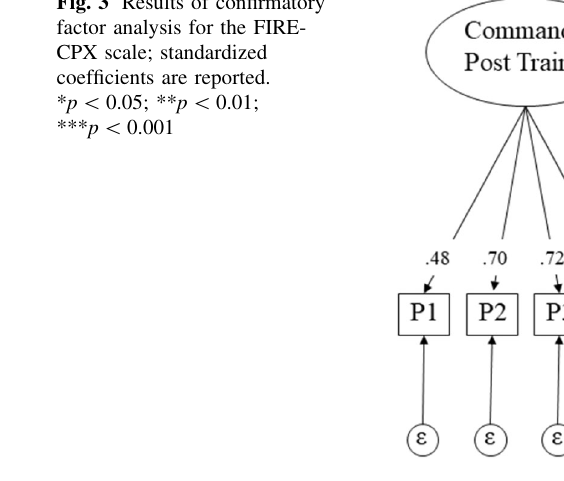
Fig. 3 Results of confirmatory factor analysis for the FIRE- CPX scale; standardized coefficients are reported. * p \ 0.05; ** p \ 0.01; *** p \